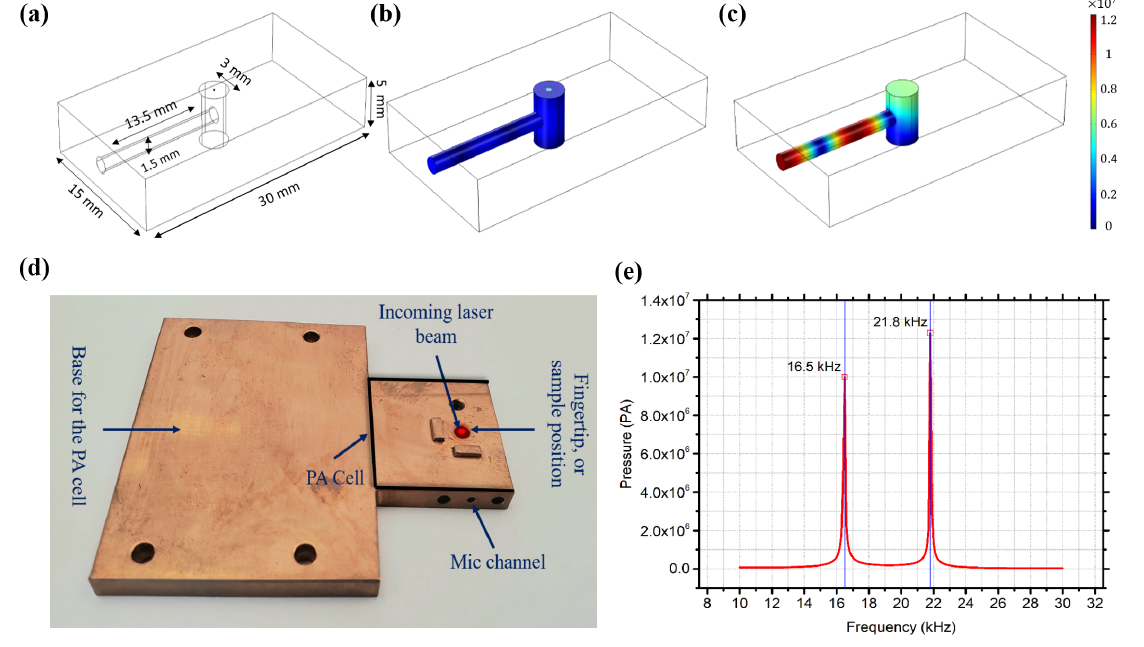
Figure 3. ( a ) PA cell sketch. ( b ) PA off-resonance. ( c ) PA on-resonance. ( d ) Fabricated copper acoustic cell. ( e ) Simulated resonance frequencies of the PA